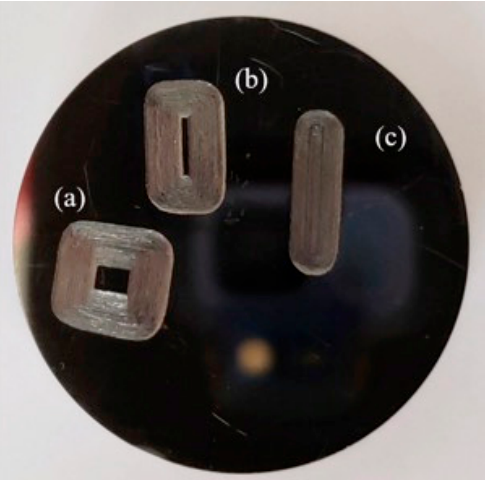
Figure 10. Wear tracks after 5000 testing cycles: ( a ) 5 mm × 5 mm, ( b ) 3 mm × 7 mm, ( c ) 1 mm × 9 mm patterns.